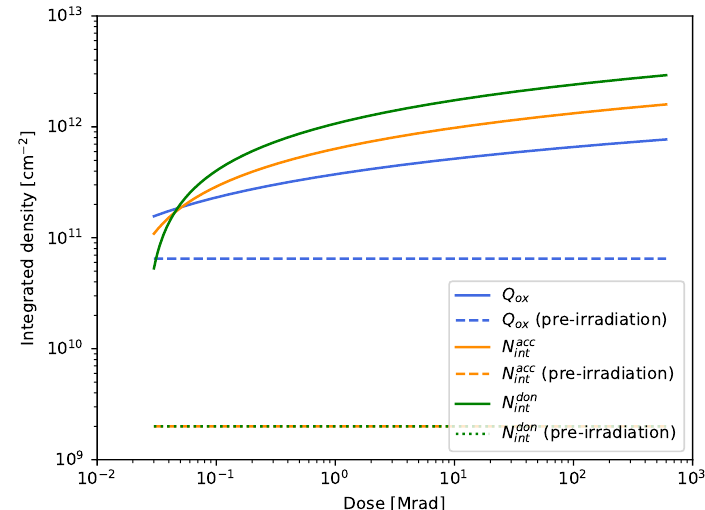
Figure 7. Dependence of the oxide charge density Q ox , acceptor integrated interface trap state density N acc , and donor integrated interface trap state density N don int damage model described by Passeri et al. [41]. Pre-irradiation values are shown as horizontal dotted